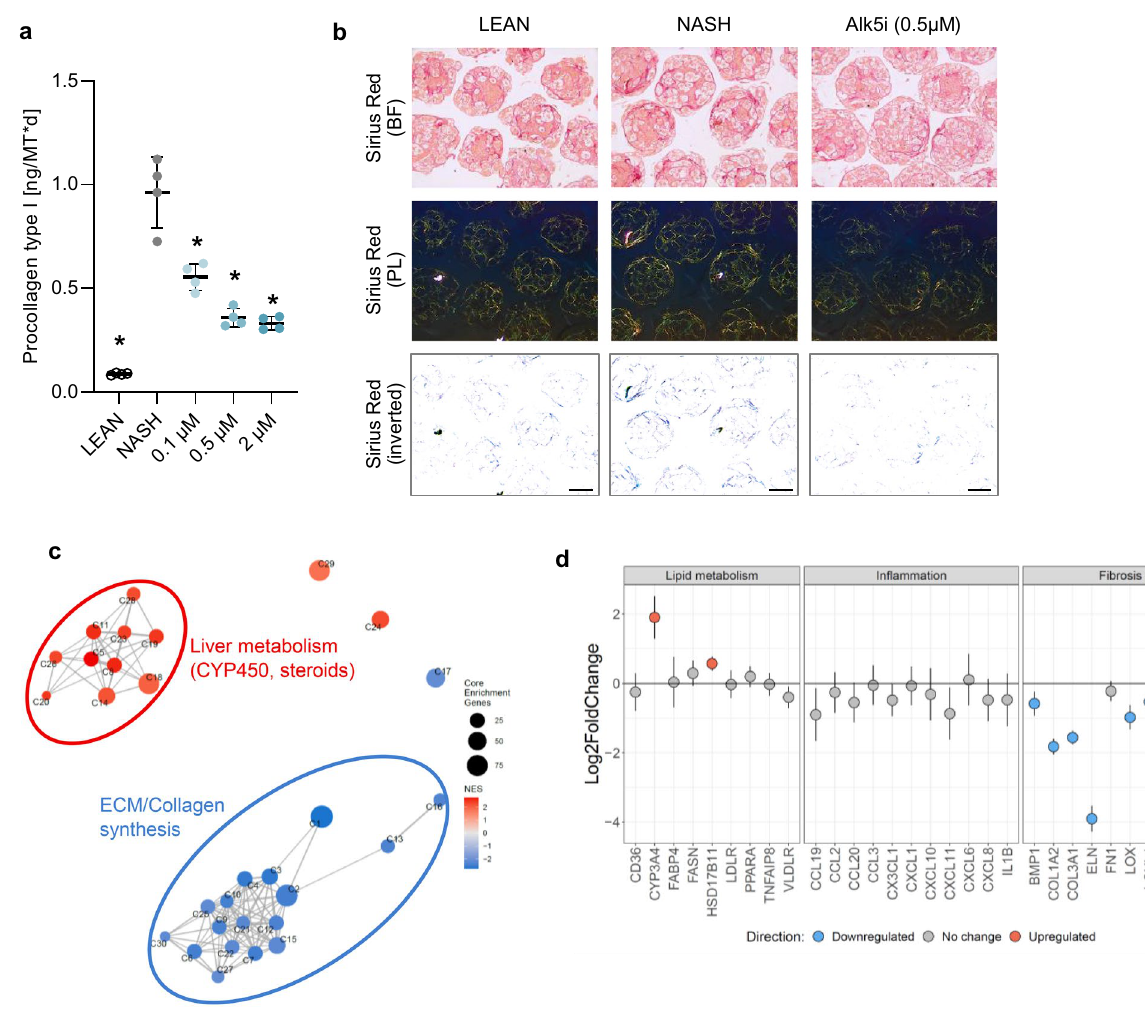
Figure 8. Effect of ALK5i on fibrosis progression in NASH hLiMTs. ( a ) Procollagen type I secretion was quantified in the supernatants on days 7 and 10. ALK5i decreased secretion concentration-dependently, (0.1 µM, 0.5 µM, 2 µM, *p < 0.05). ( b ) Polarized light microscopy of Sirius Red-stained tissue sections. There was a reduction of collagen fibrillation in ALK5i-treated NASH hLiMTs compared to non-treated NASH hLiMTs. Scale bars indicate 100 μm. ( c , d ) Transcriptomic profiling of ALK5i treatment (0.5 µM) in the 3D NASH model. ( c ) Enrichment map of gene sets derived from GSEA comparing ALK5i-treated NASH hLiMTs to non-treated NASH hLiMTs on day 10 of treatment. The 30 most significantly regulated gene sets are displayed. Color scale represents NES. Red nodes represent gene sets upregulated upon ALK5i treatment, whereas blue nodes represent gene sets downregulated. The size of the nodes depicts the numbers of core enrichment genes. Nodes are grouped by their similarity, with connecting lines representing common genes between nodes. Clusters of functionally related nodes were summarized and annotated. Full gene set lists are provided in Supplementary Table S5. ( d ) Expression profile of key genes associated with lipid metabolism, inflammation and fibrosis. Plots show log2 fold change between ALK5i-treated NASH hLiMTs compared to non-treated NASH hLiMTs on day 10 of treatment. Error bars represent 95% confidence intervals associated with log2 fold change values. Blue indicates significant downregulation and red significant upregulation in ALK5i-treated NASH samples (FDR < 0.05). Data points are derived from single microtissues (n =